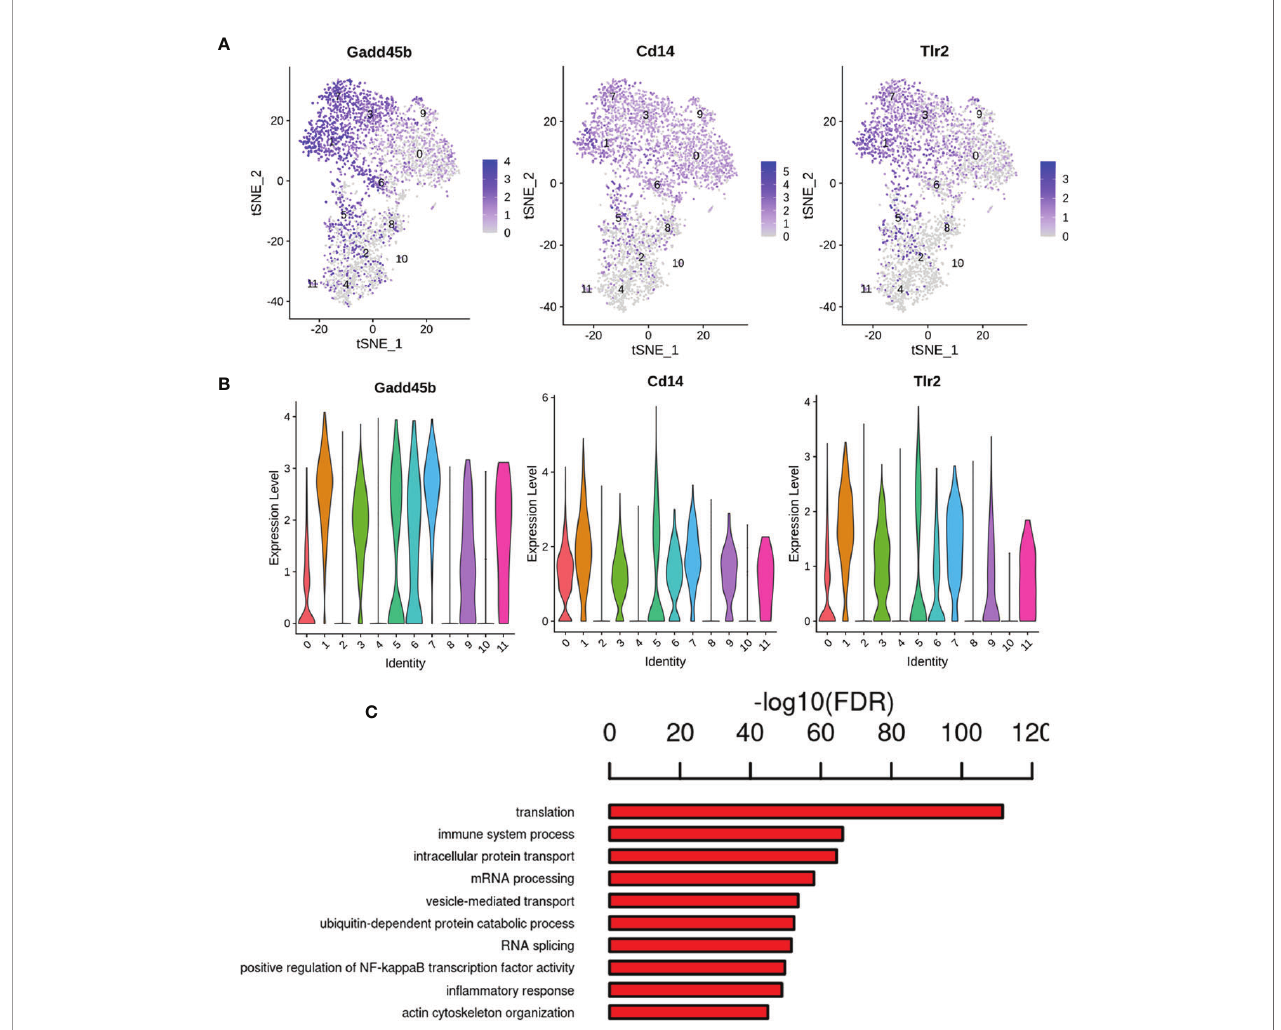
FIGURE 8 | Gene expression pattern analyses in cluster 1. (A) Feature plot of in fl ammation marker genes Gadd45b, Cd14 and Tlr2 in cluster 1. (B) Violin plots revealed the expression of in fl ammation marker genes for 1 cluster. (C) The enriched GO terms of cluster 1 are